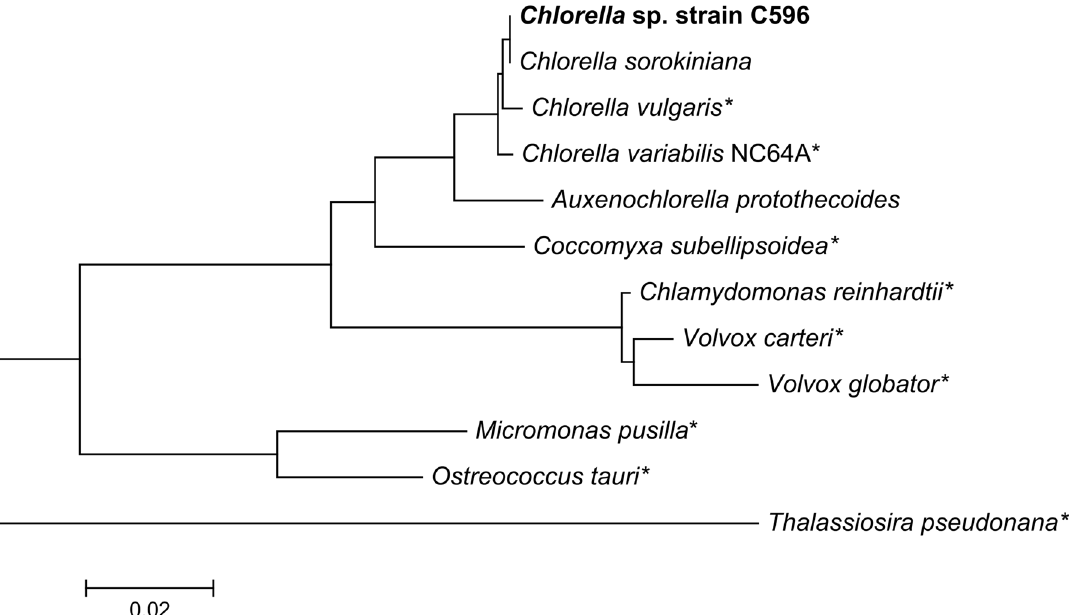
Fig 1. 18S rRNA phylogenetic tree for marine and freshwater green algae and a marine diatom outlier. The asterisks indicates organisms with available genomes in the NCBI database. The representative full-length 18S rRNA sequences were aligned with MUSCLE in MEGA 6.